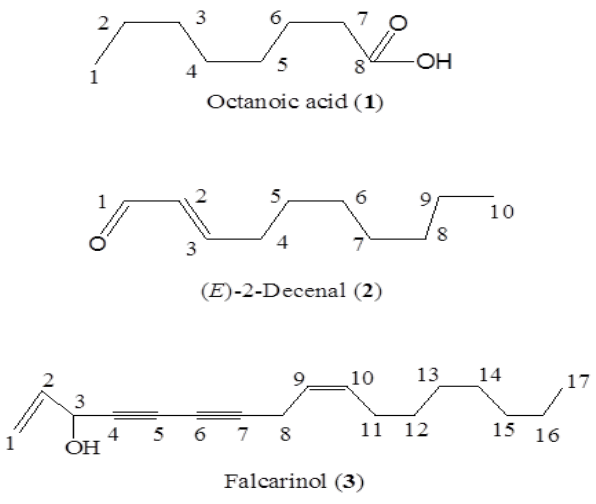
Figure 1. Structure of the extracted compounds.